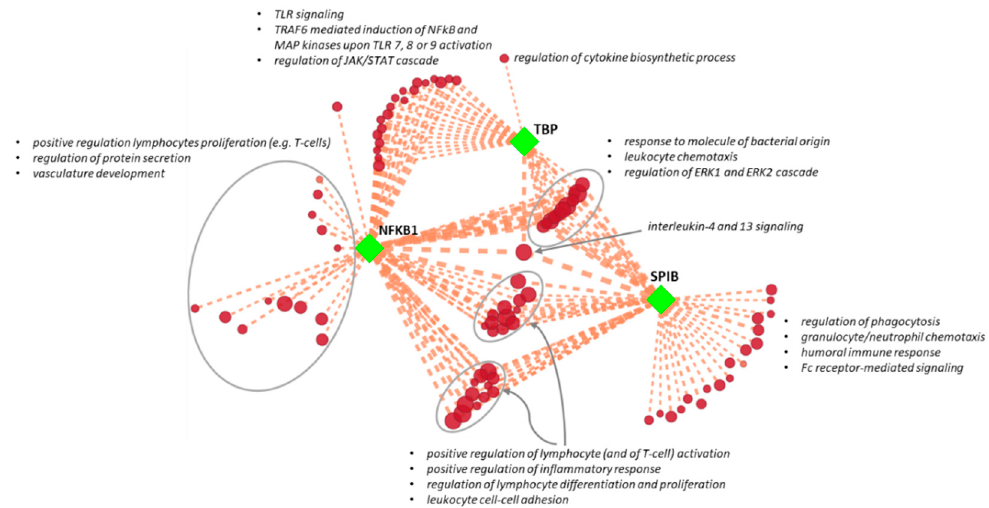
Figure 5. Enrichment network of transcriptional clusters. NFKB1, SPIB, and TBP transcriptional clusters (squared green nodes) and pathogenetic Gene Ontology–biological process (GO-BP) pathways associated with abdominal aortic aneurysm perivascular adipose tissue (red nodes) are connected by dashed orange edges, which indicate significant overlaps between two gene sets. Edge thickness (from thinner to thicker) is proportional to the number of overlapping genes. GO-BP pathway node colors (from lighter to darker) and sizes (from smallest to bigger) are proportional to the original normalized enrichment score calculated by gene set enrichment analysis. Groups of redundant gene sets were manually circled and labeled by relevant overview GO-BP pathways terms.